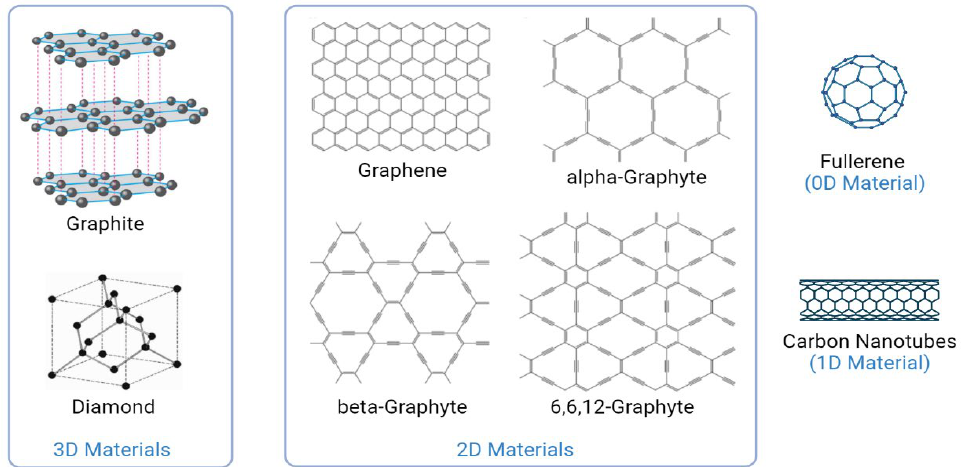
Figure 1. Chemical composition of graphene and processes in which it is involved. Graphene comprises a hexagonal carbon atom arrangement, which can form zero-, one-, and three-dimensional structures. Reprinted with permission from ref. [69]. Copyright 2012 American Physical Society .